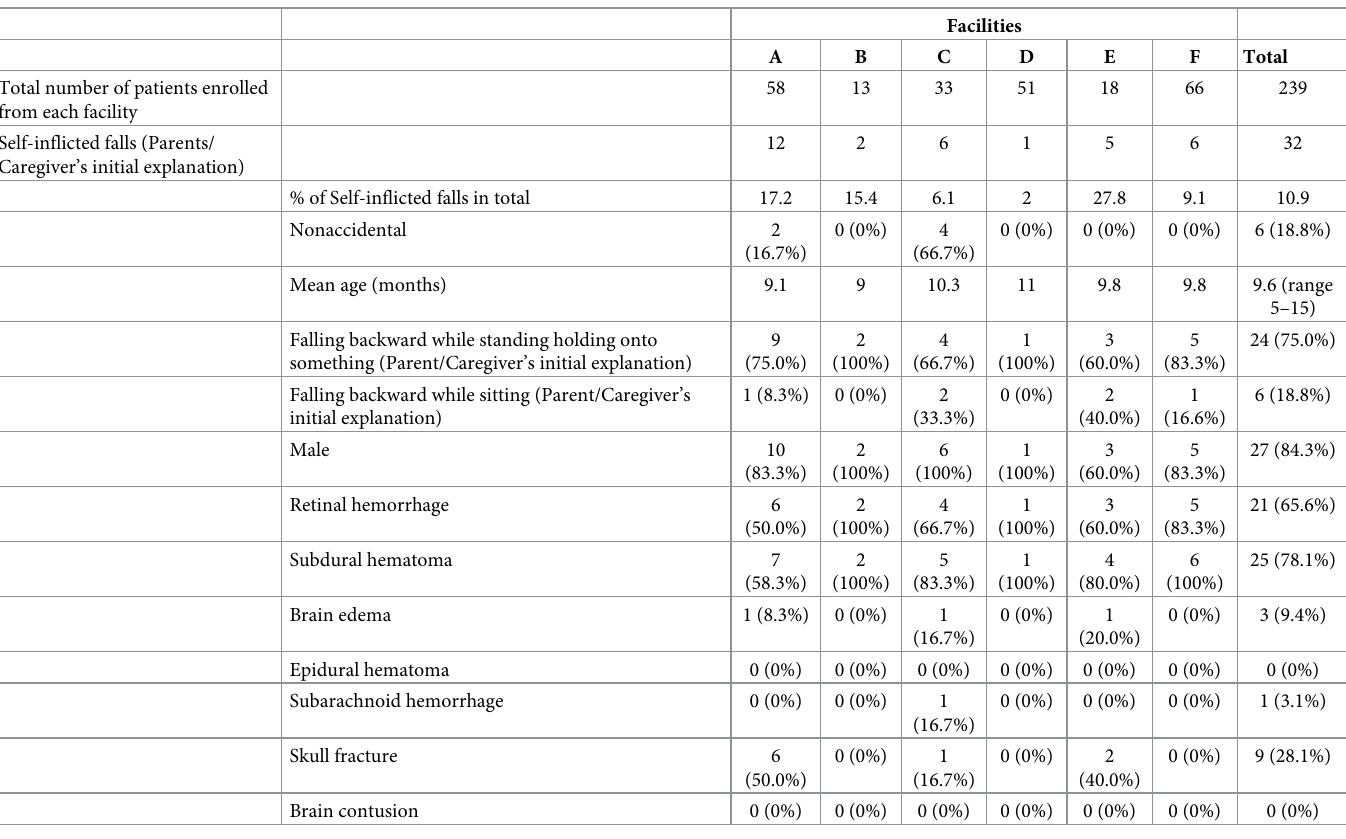
Table 5. Number and characteristics of self-inflicted falls by each facility.